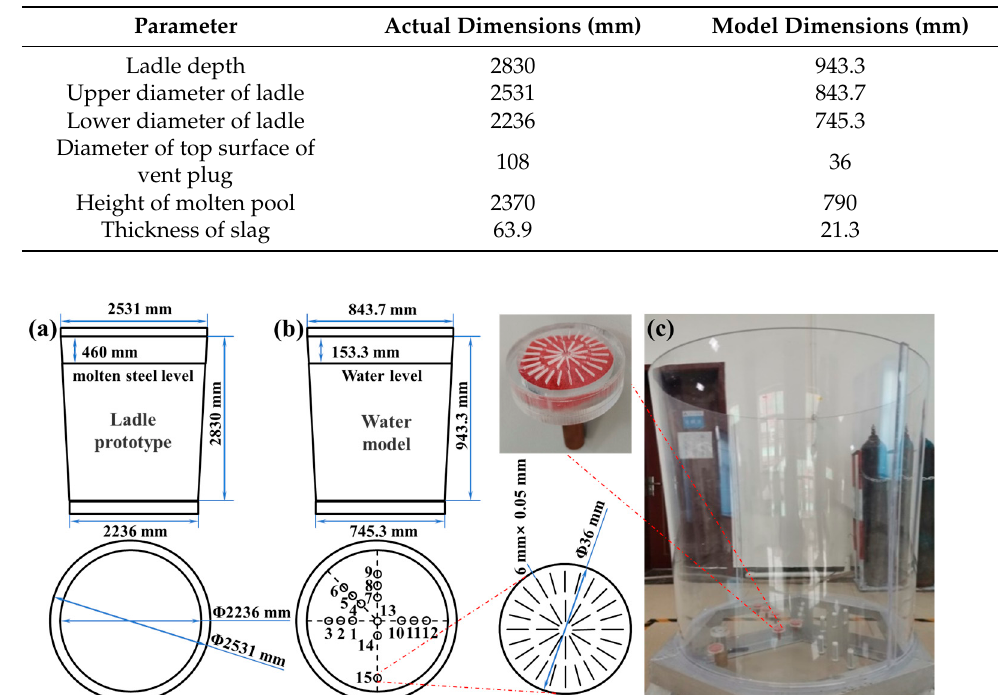
Figure 2. ( a ) prototype dimensions, ( b ) model dimensions and ( c ) model physical objects. Table 2. Position and number of blow holes at the bottom of water